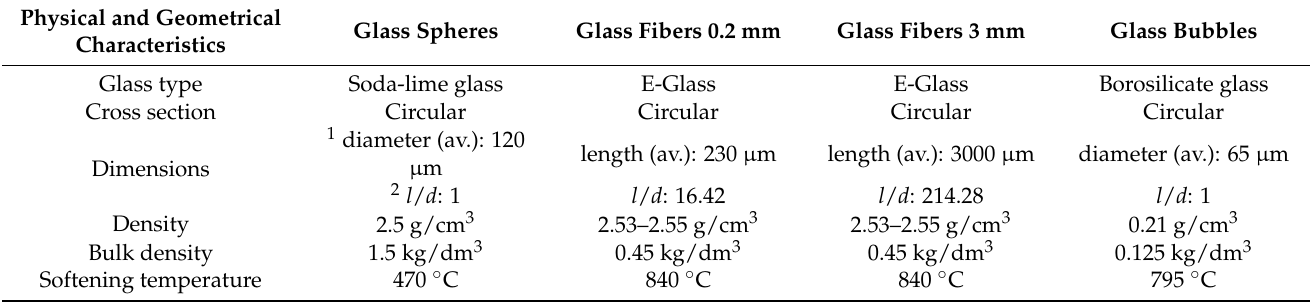
Table 2. Physical and geometrical characteristics of glass fillers